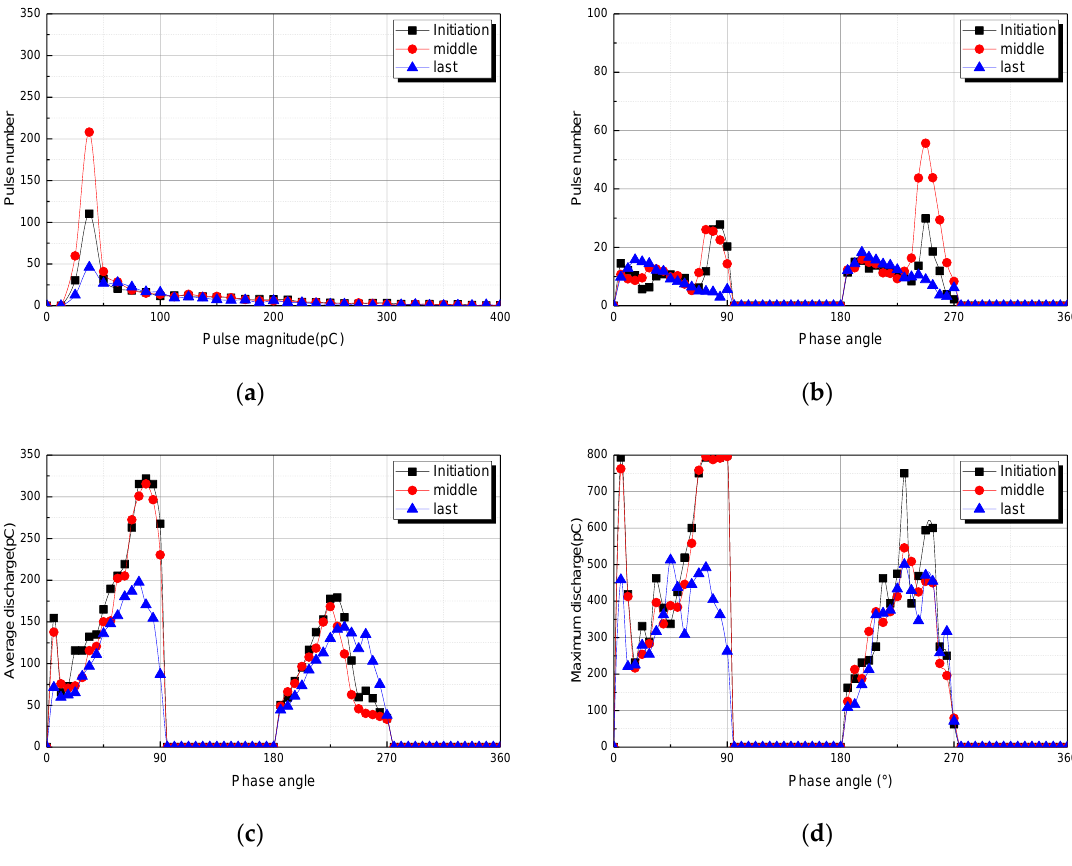
Figure 6. Statistical distributions of PD for tree model 3: ( a ) Hn(q) distribution; ( b ) Hn(Φ) distribution; ( c ) Hq n (Φ) distribution; ( d ) Hq max (Φ) distribution.